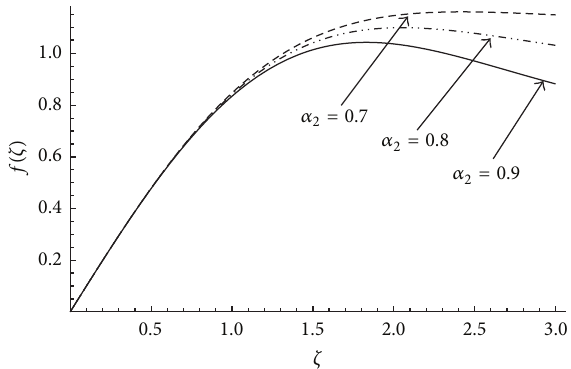
Figure 3: The effect of changing 𝛼 2 on the solution 𝑓(𝜁) at 𝛼 1 = 0.9 , 𝛼